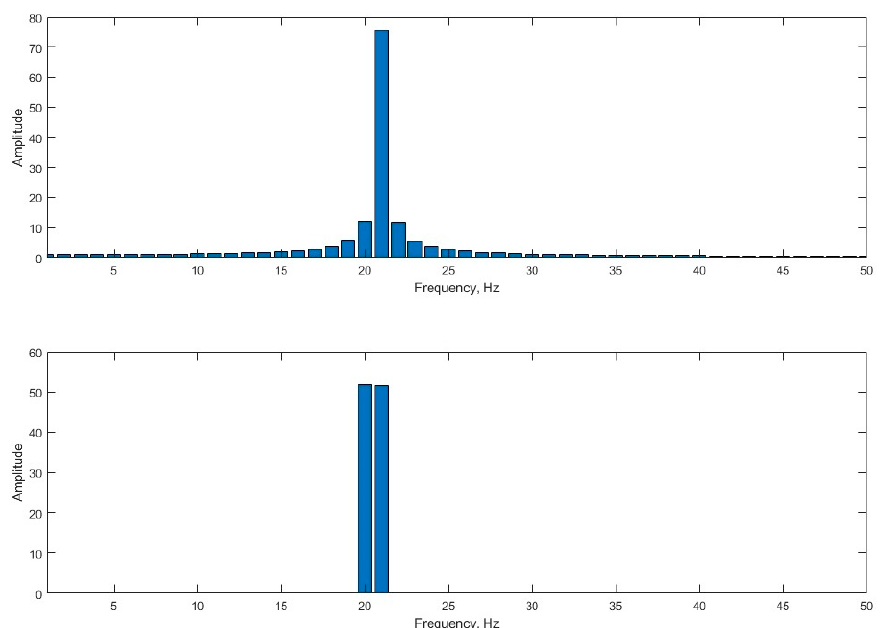
Figure 17. DFT (up) and NC (down) spectrum of two mono-harmonic signals, with 19.8 and 20.2 Hz.